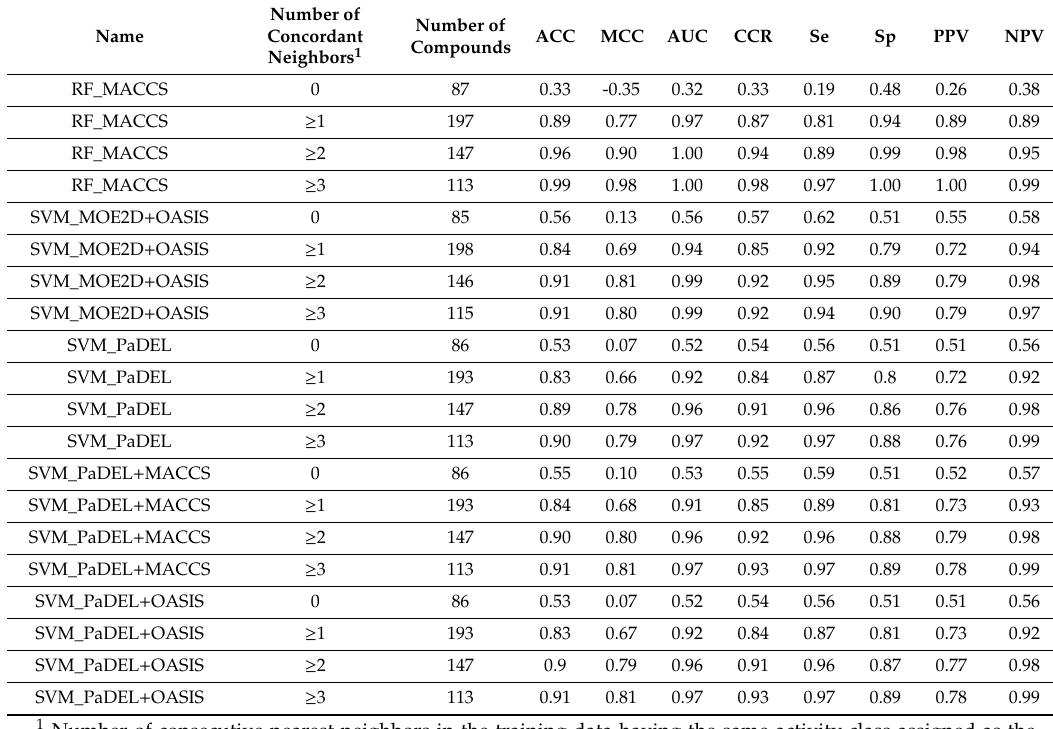
Table 8. Test set performance as a function of the number of consecutive nearest neighbors with class assignments consistent with the predicted